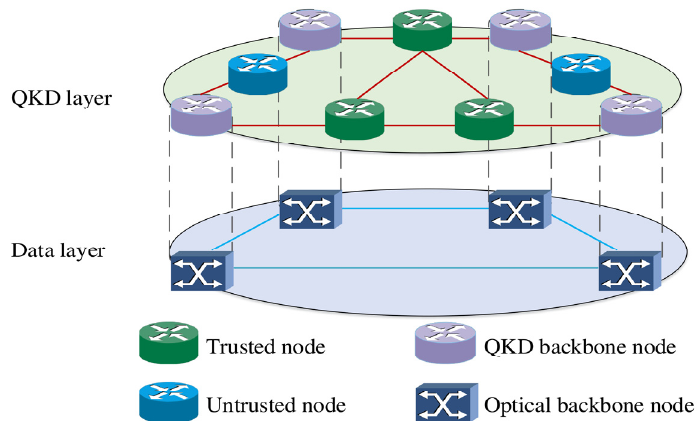
Figure 2. QKD network based on partially trusted relays.